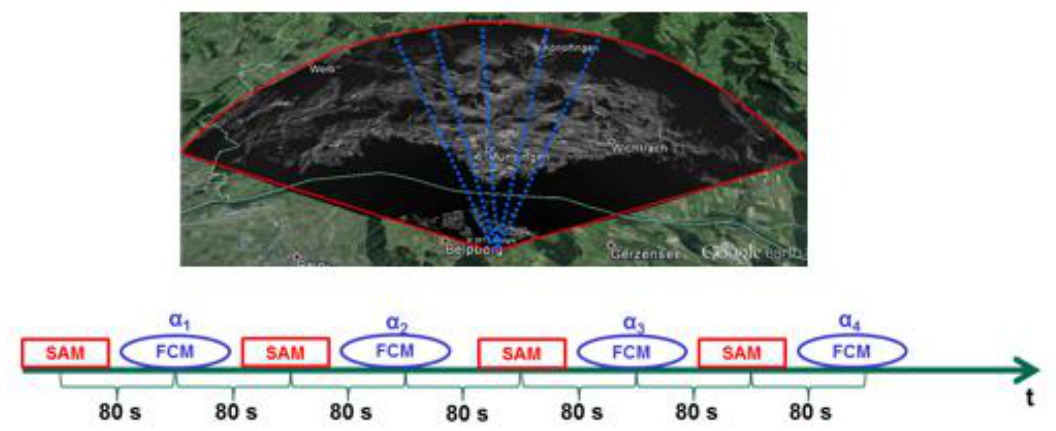
Figure 7. Operating modes of the real aperture, Ku-band radar used for the measures shown in Figures 5–9. Upper panel: example of a radar image. Lower panel: timeline, which results from interleaving every 80 s one observation at fixed pointing, named Fixed Clutter Mode (FCM), and one with an entire full aperture scan, named Scanning Aperture Mode (SAM).